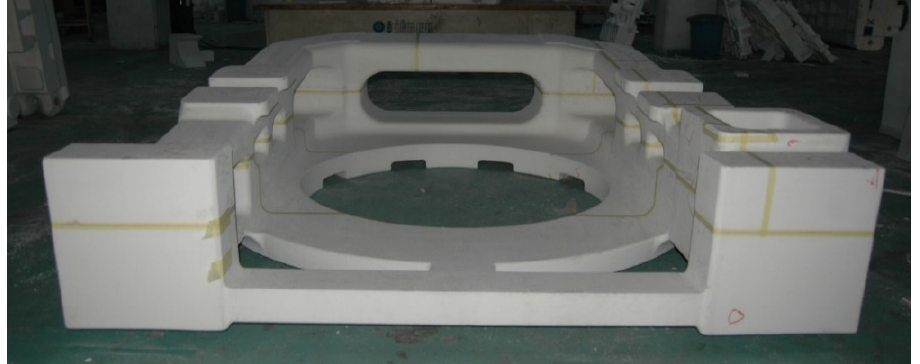
Figure 13. The lost foam casting mold which was prepared for the casting project.